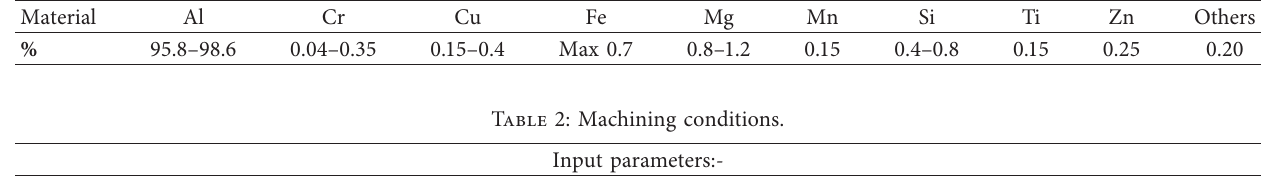
Table 1: Al6061-T6 alloy chemical composition.